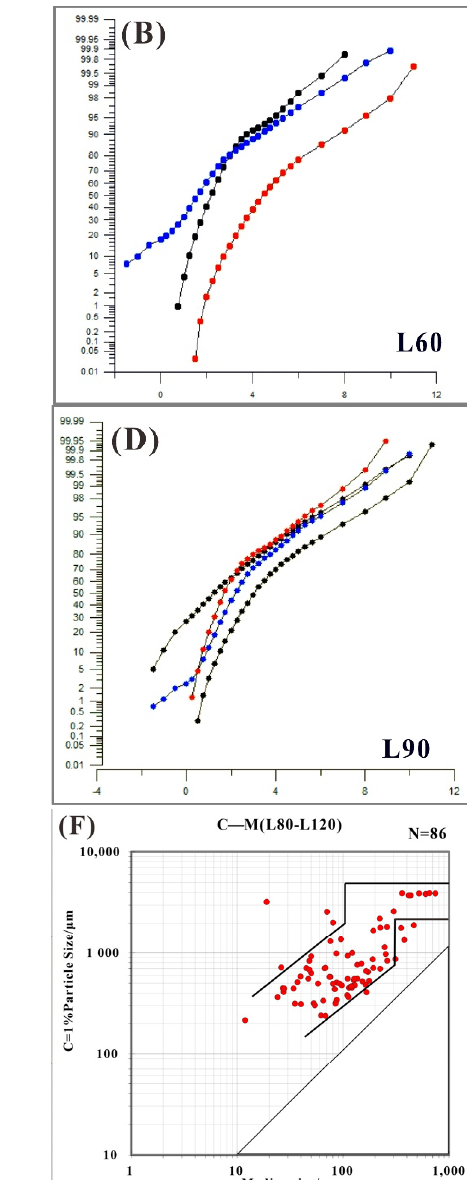
curves of the PL19 − 3 − B well. ( C ) The probability cumulative grain size curves of the PL25 − C